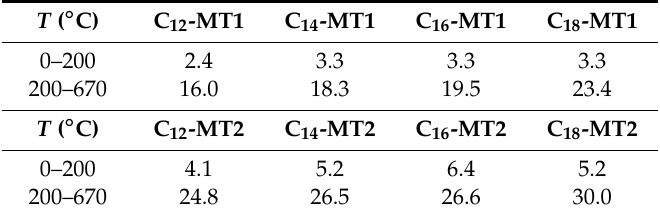
Table 5. The mass loss of organo-MT at di ff erent temperature range (wt